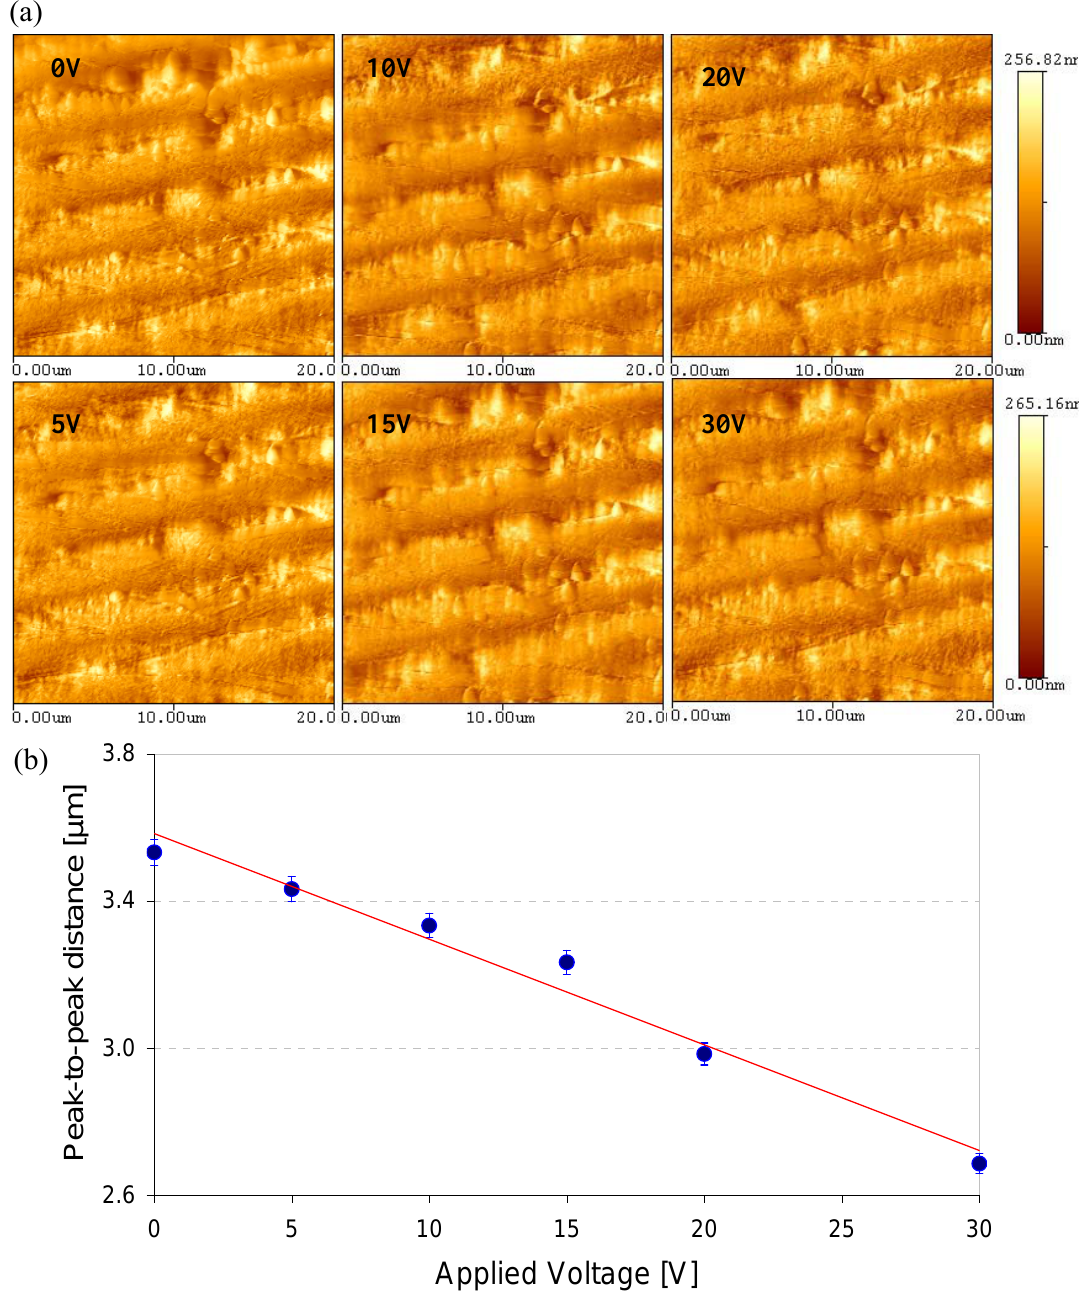
Figure 6. Investigation of the surface change rate with the applied voltage. (a) AFM images for a PVDF sample which was 52µm thickness with 150nm Au coated. (b) The change of the peak- ) with the external electrical to-peak distance (D pp